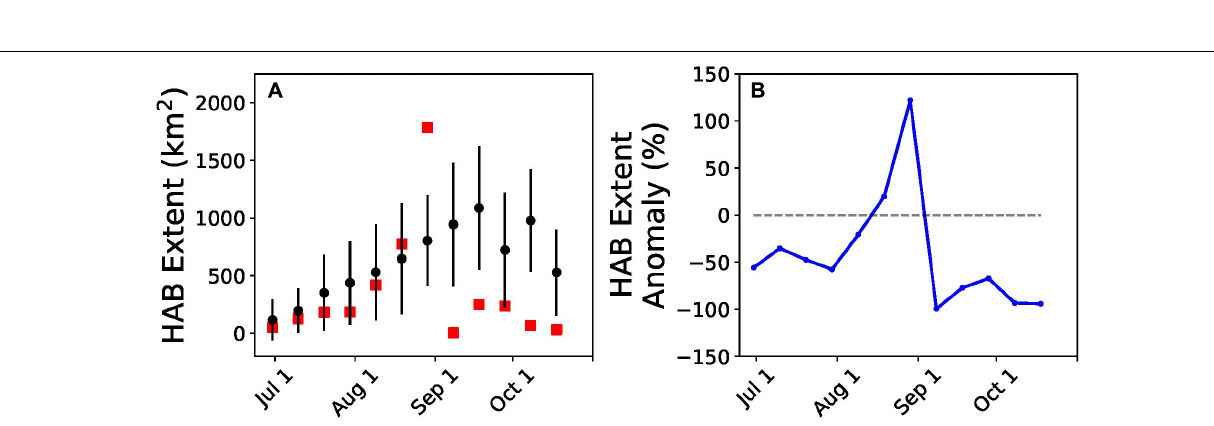
FIGURE 7 | Panel (A) shows median WBLE harmful algal bloom (HAB) extent for the 10-day windows starting from June 30 to October 17. The red squares represent the 2020 extents and the black dots represent the mean of prior years’ (2012–2019) extents. The vertical black lines represent the standard deviations of the prior years’ extents. Panel (B) shows the anomaly time series for the HAB